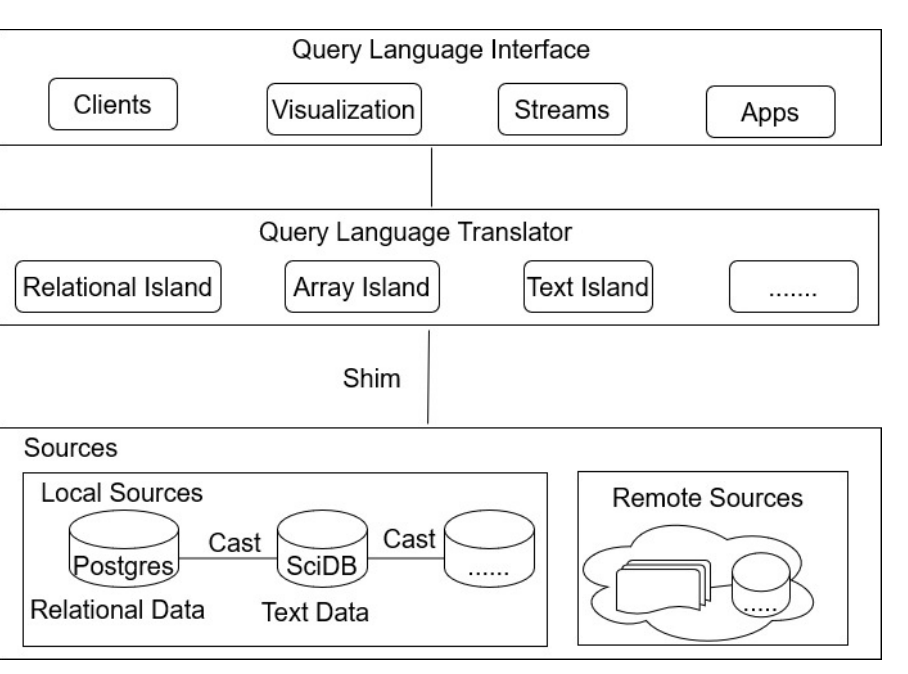
Figure 1. Polystore